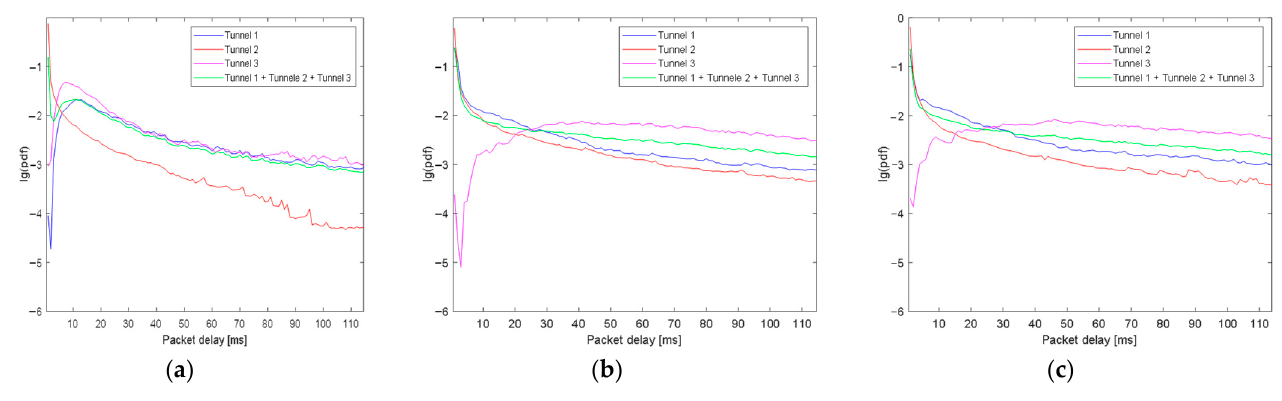
Figure 16. Statistical characterization of the packet delays on the aggregated virtual tunnels when 3 APs and different user clustering algorithms are used: ( a ) The pdfs of the packet delays when no user clustering algorithm is used; ( b ) The pdfs of the packet delays when the cooperative user clus- tering algorithm with 1 dB power adjustment step is used; ( c ) The pdfs of the packet delays when the cooperative user clustering algorithm with 2 dB power adjustment step is used.